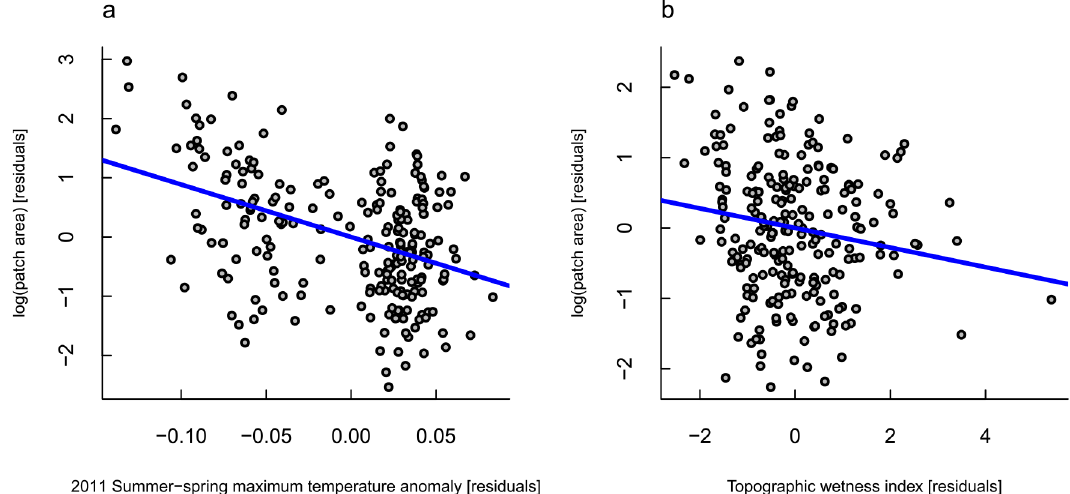
Fig 3. Partial-regression plots from the final regression model of drought impact patch size as a function of environmental variables related to water availability: (a) the independent effect of the 6-month average daily temperature maxima at the time of the drought, expressed as an anomaly from the long-term mean; and (b) the independent effect of the topographic wetness index on patch sizes.